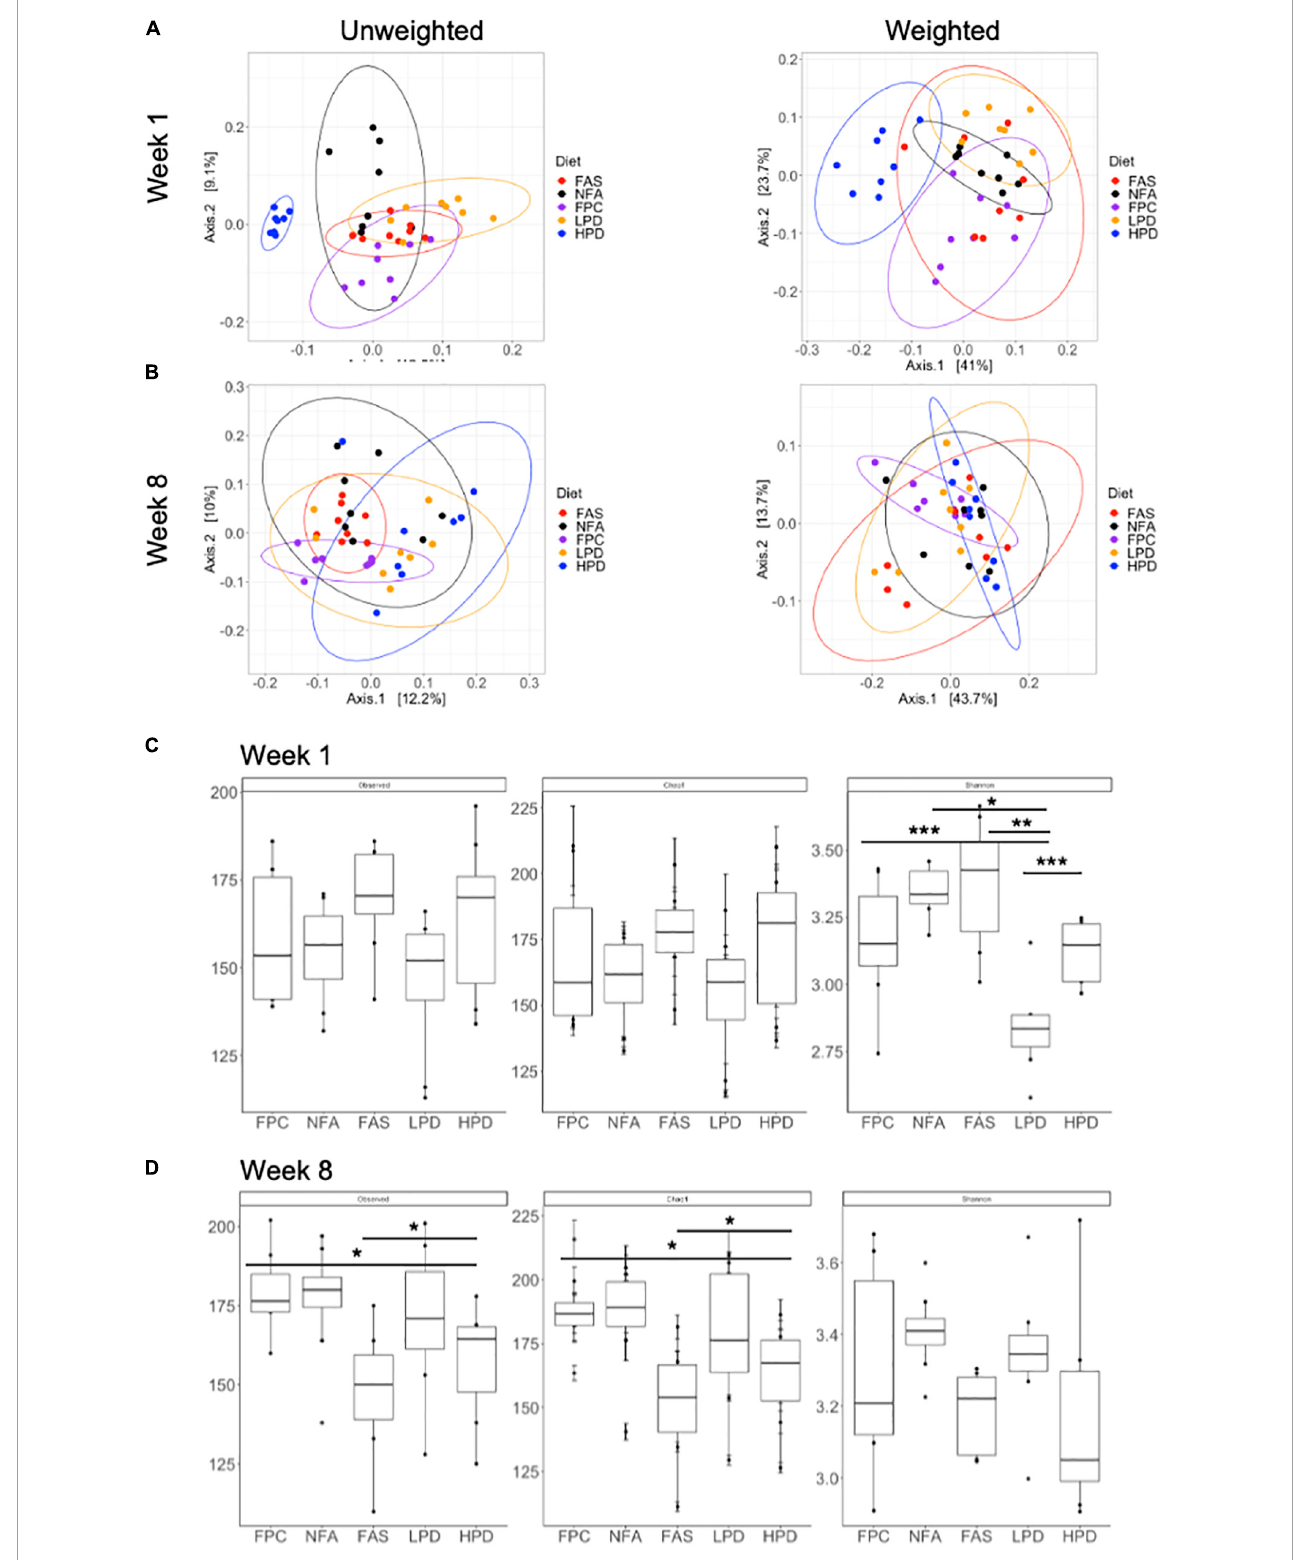
FIGURE5 Alpha and beta diversity of the fecal microbiota across diets at weeks 1 and 8. (A) Unweighted unique fraction metric (UniFrac) and weighted UniFrac principal coordinates analysis (PCoA) at week 1 ( p ≤ 0.05) and (B) week 8 ( p ≤ 0.05) across all groups (FPC, FAS, NFA, LPD, and HPD). FPC is the control group. p ≤ 0.05 suggests the clustering scheme across all groups is significant. There is no post hoc test for PERMANOVA. Alpha diversity (Observed, Chao1, and Shannon Diversity Index) of the fecal microbiota at (C) week 1 (Shannon diversity: p < 0.05 NFA relative to HPD and LPD; p < 0.01 FAS relative to LPD; p < 0.001 FPC relative to LPD and LPD relative to HPD) and (D) week 8 (Observed ASVs p < 0.05 FPC relative to HPD and FAS relative to HPD; Chao1: p < 0.05 FPC relative to HPD and FAS relative to HPD). FPC is the control group * p ≤ 0.05; ** p ≤ 0.01; *** p ≤